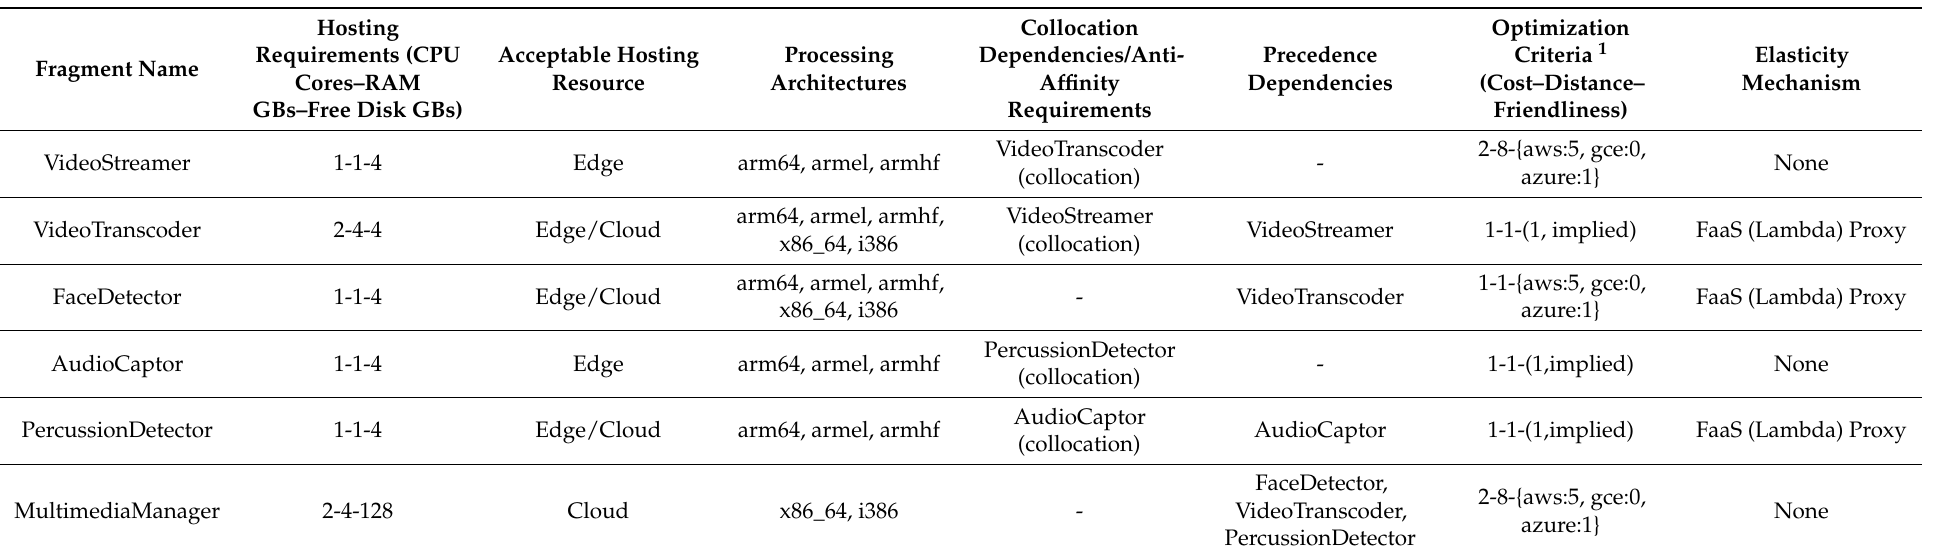
Table 2. Fragment processing requirements and